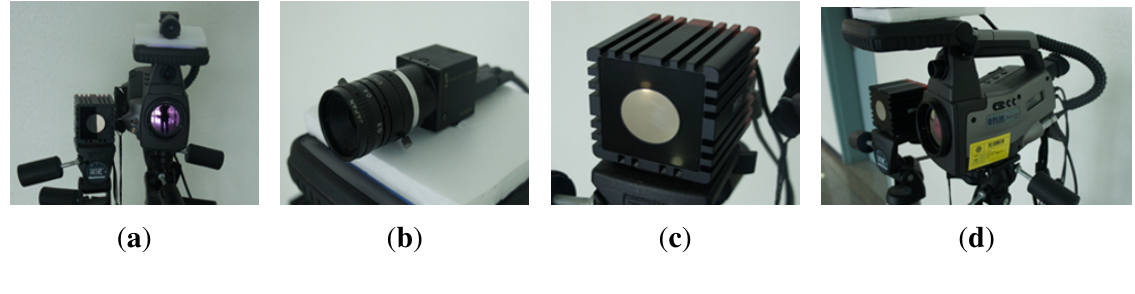
Figure 12. The proposed system: ( a ) proposed full system; ( b ) visible camera; ( c ) ToF camera; and ( d ) thermal-IR camera.